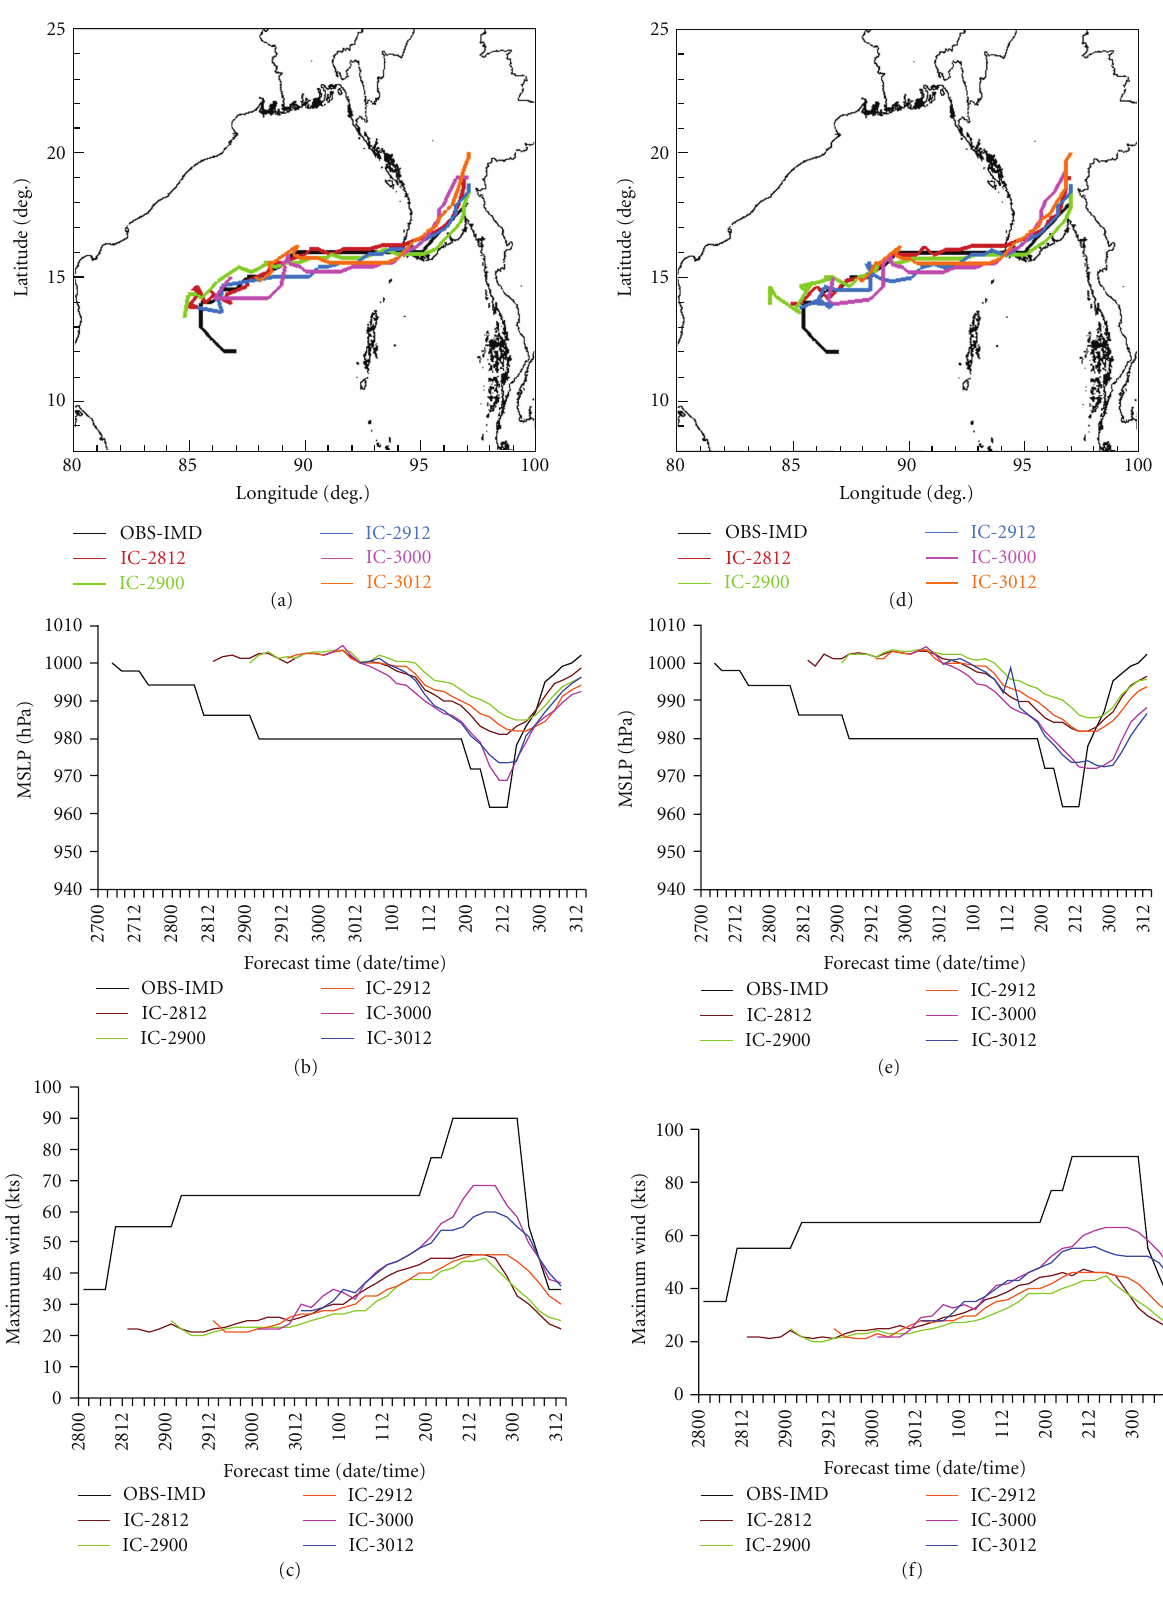
Figure 7: (a) Track, (b) MSLP (hPa), and (c) maximum wind (kts) of the cyclone NARGIS with S cumulus convections, Y PBL, NMM land surface scheme, and Ferrier microphysics option at di ff erent initial conditions; (d), (e), and (f) are same as (a), (b), and (c) but with NOAH land surface